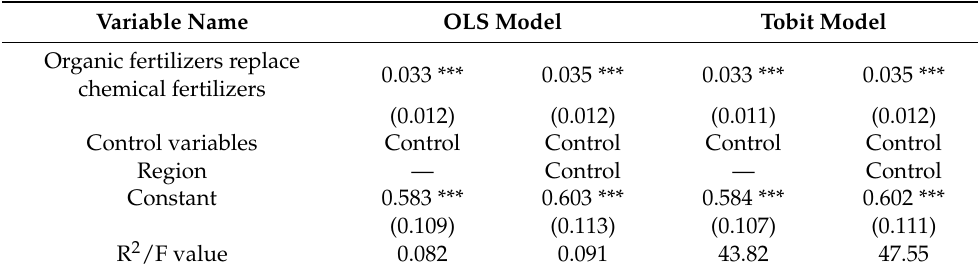
Table 7. Estimates results based on OLS model and Tobit model.